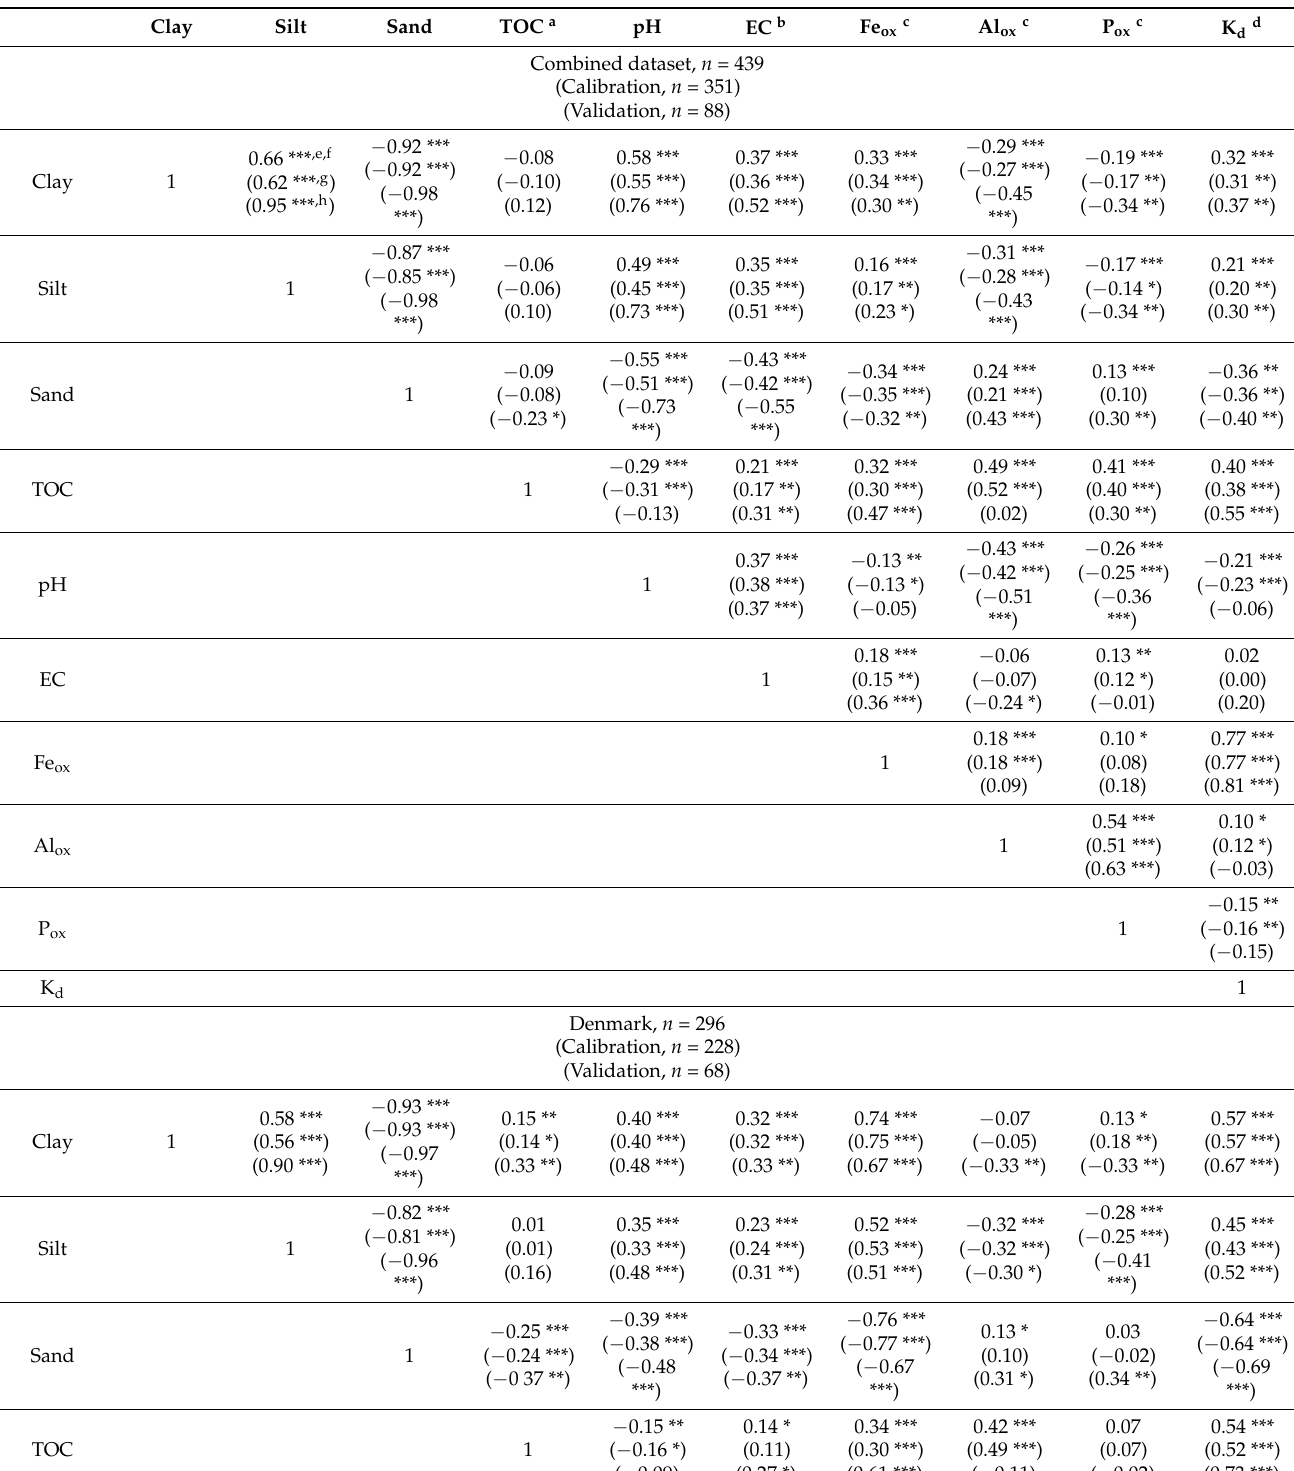
Table A1. Pearson’s correlation matrix of soil physicochemical properties for the combined, Danish, and Greenlandic datasets (including their calibration and validation